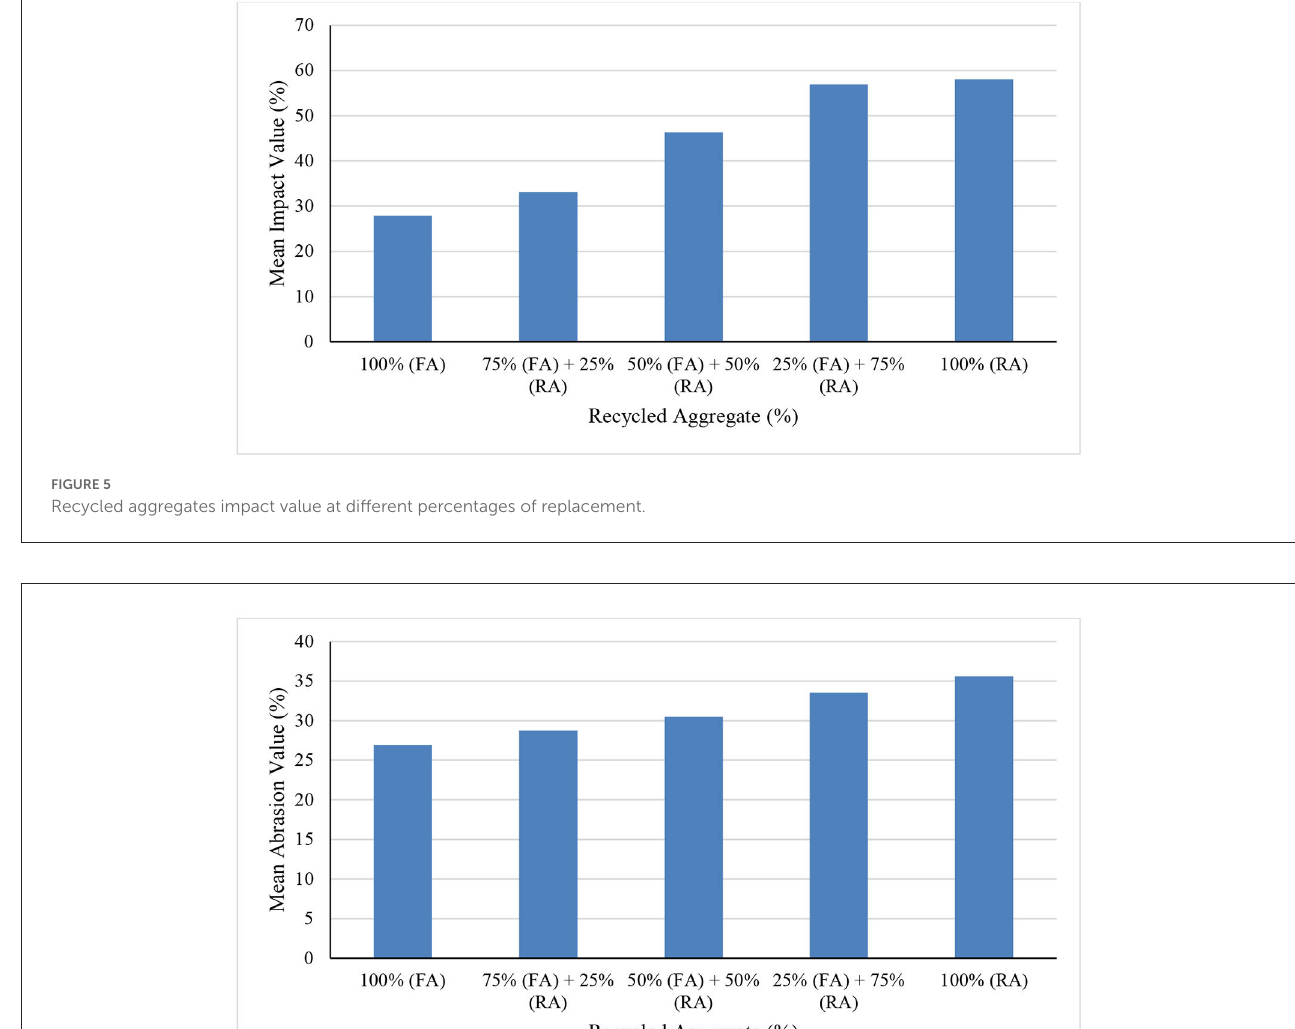
pavements was demonstrated by test results (Hoyos et al.,